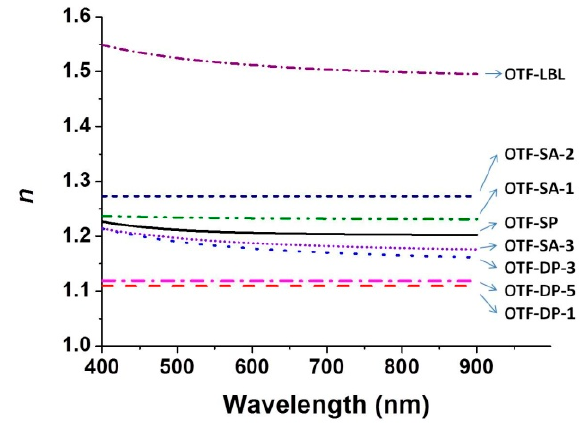
Figure 3. Efficient refractive index of MOF optical thin films. Table 2. Average efficient refractive index ( n ave ), specific efficient refractive index at 900 nm ( n 900 ), and calculated voids of MOF optical thin films.